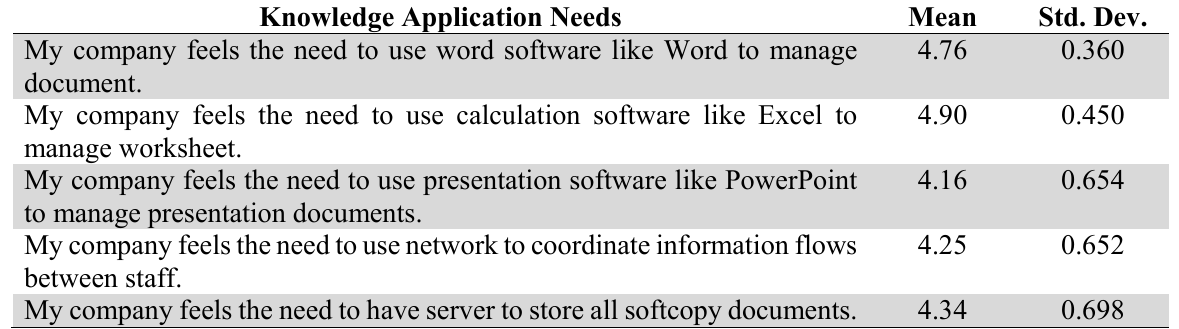
Mean and Standard Deviation for “Knowledge Application Needs” Knowledge Application Needs